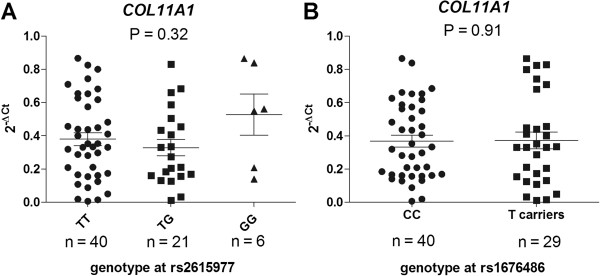
Columnar scatter plot of the quantitative expression of COL11A1 in cartilage cDNA stratified by genotype at A) the OA associated SNP rs2615977 and B) the LDH associated SNP rs1676486. Due to the low frequency of TT homozygotes at rs1676486 the analysis in B) was between CC homozygotes and T-allele carriers (CT and TT combined) at this SNP. n is the number of patients studied for each group. The horizontal lines in each plot represent the mean and the standard error of the mean. P-values were calculated using a Kruskal-Wallis test for A) and a Mann–Whitney U test for B).